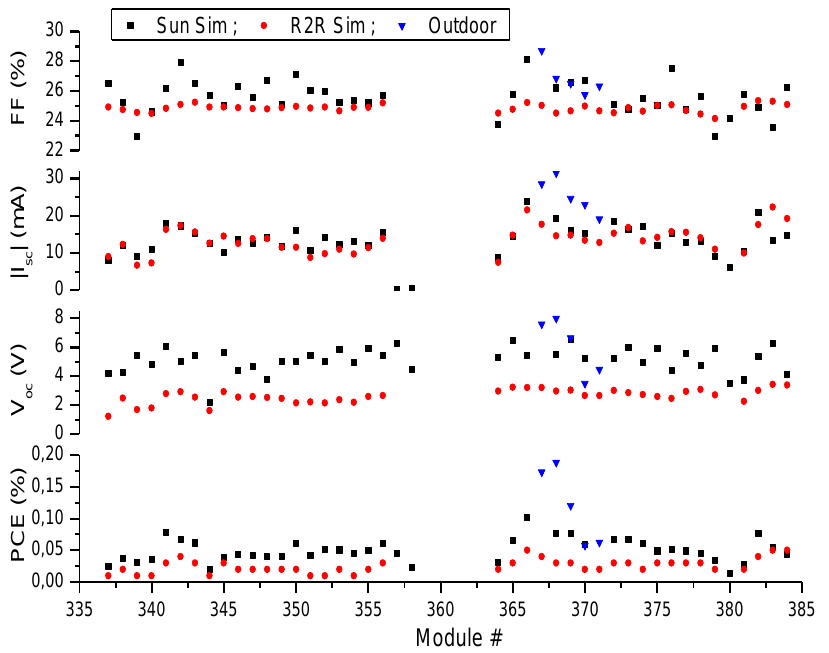
Figure 8. Comparison of the open-circuit voltage, V fill-factor, FF , and the photon conversion efficiency, PCE , for R2R modules made with a VTIP concentration of 15 mg/mL. They were measured under two different sun simulators and 5 modules (367–371) were measured in outdoor conditions as